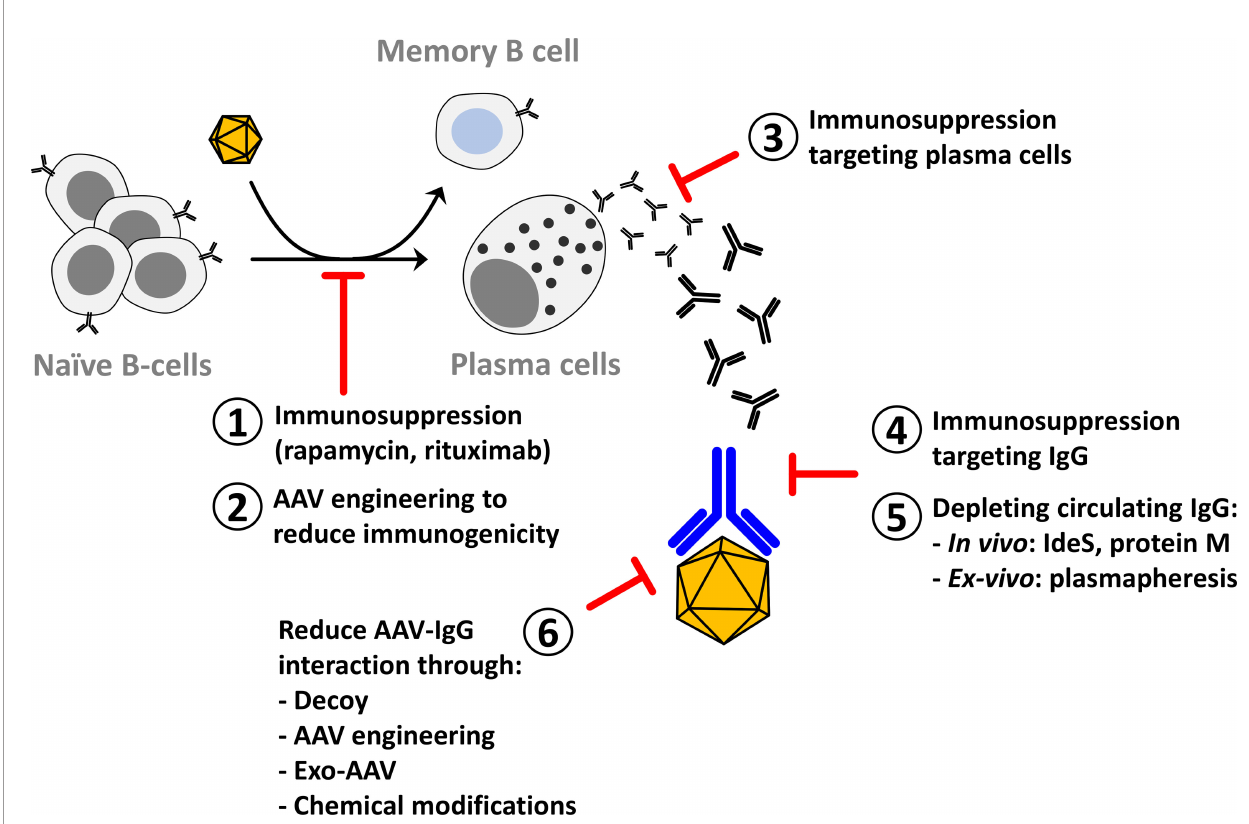
FIGURE 1 | Methods to reduce the impact of anti-AAV neutralizing antibodies on AAV gene transfer. After AAV gene transfer in seronegative individuals naïve B-cells are activated to plasma cells that are specialized in antibody secretion. Part of the activated B-cells become memory B-cells that participate in the long-term stability of the humoral response. Methods to reduce the activation of B-cells include immunosuppression to target the CD4-mediated helper function (1) or to reduce the viability of plasma cells (3) and AAV engineering to reduce the activation of the immune system (2). Immunosuppression to reduce circulating IgG has been proposed in autoimmune diseases and can be applied in AAV gene therapy (4). Circulating IgG can also be reduced through in vivo or in vitro depletion (5). Another method to reduce the impact of anti-AAV IgG on gene transfer ef fi cacy is to modify the vector to evade neutralization